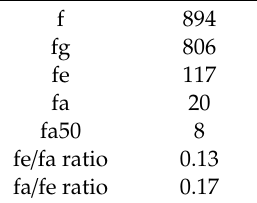
Table 1. Demographic parameters of the border collie breed in Hungary.